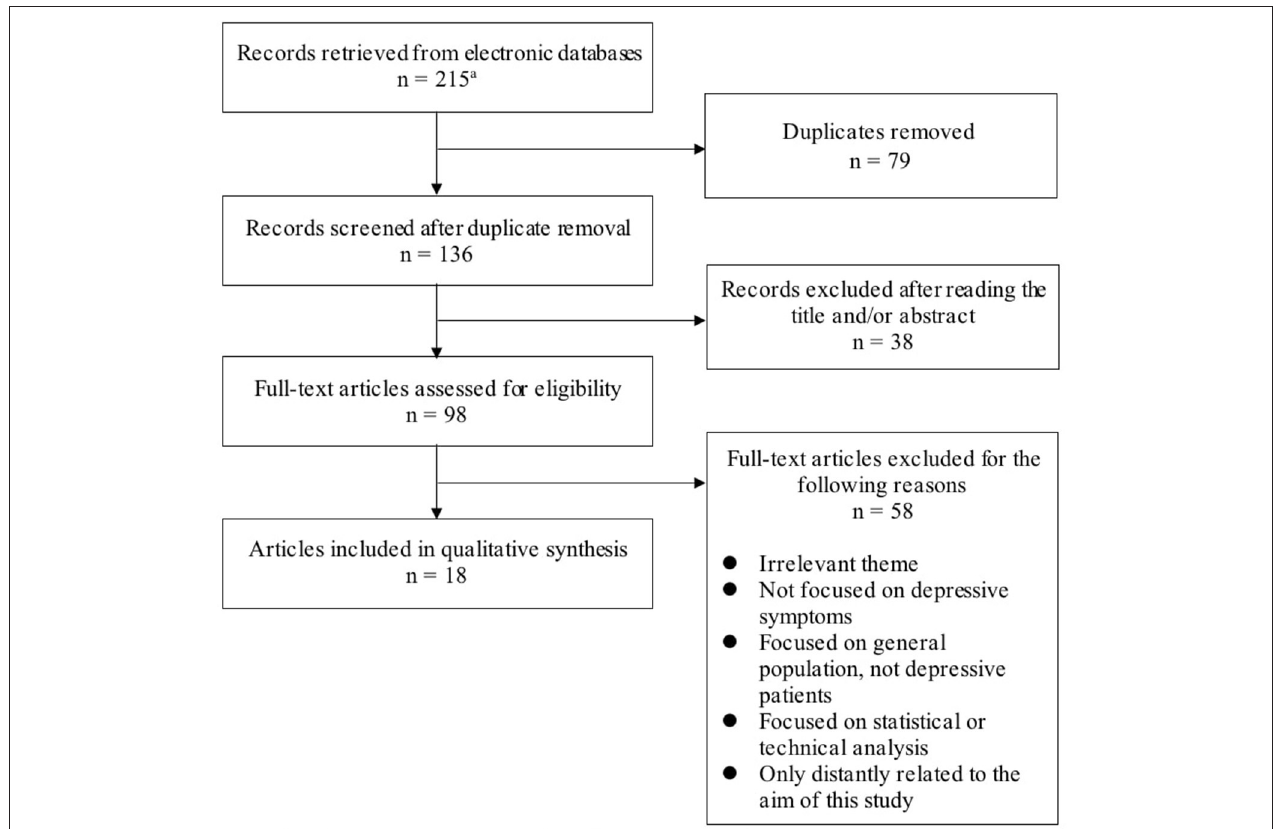
FIGURE 1 | Flow diagram of the literature search. a PubMed/Medline: n = 89; Web of Science: n =